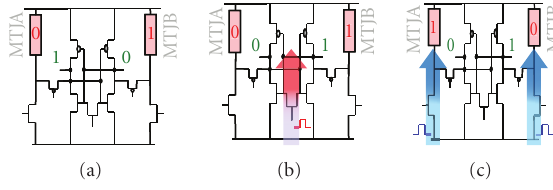
Figure 8: Shadowed reconfiguration